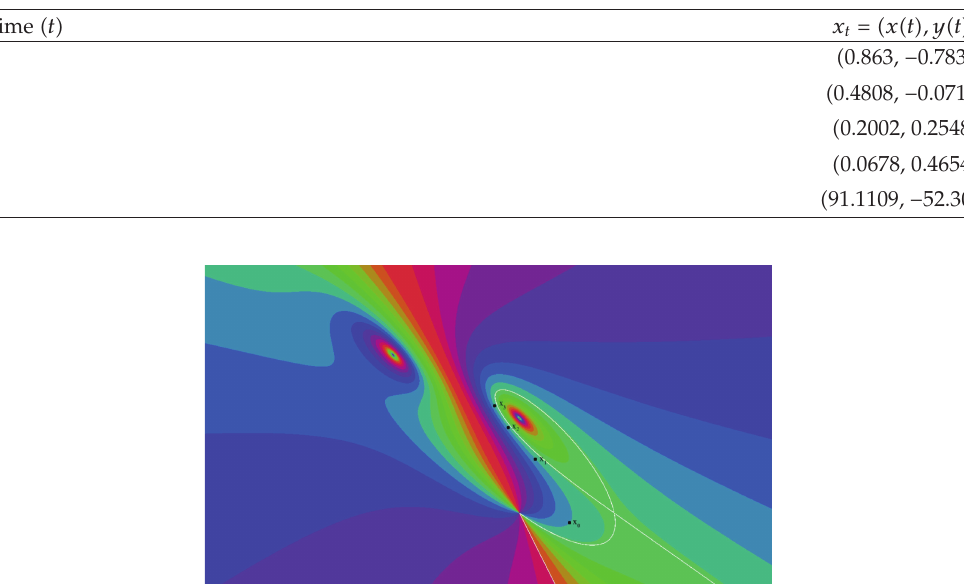
(cid:2) h (cid:3) x,y (cid:4) (cid:5) − 1 . 68195 and